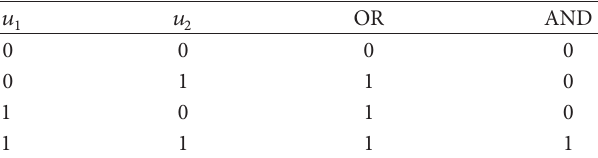
Table 1: True table for OR and AND logic gates.